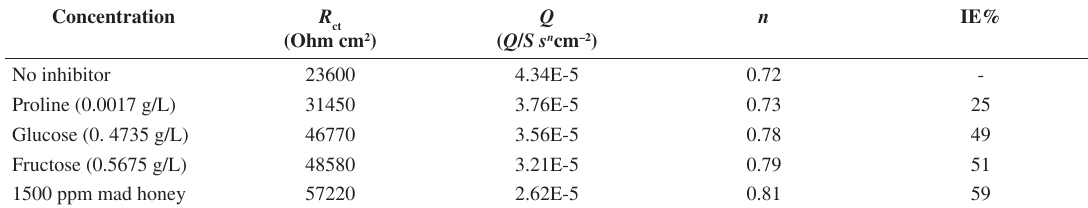
Table 7. Impedance parameters of Al-2007 alloy in 3.5% NaCl media, 1500 ppm mad honey and the quantity of the studied compounds in 1500 ppm mad honey in 3.5% NaCl media. Concentration